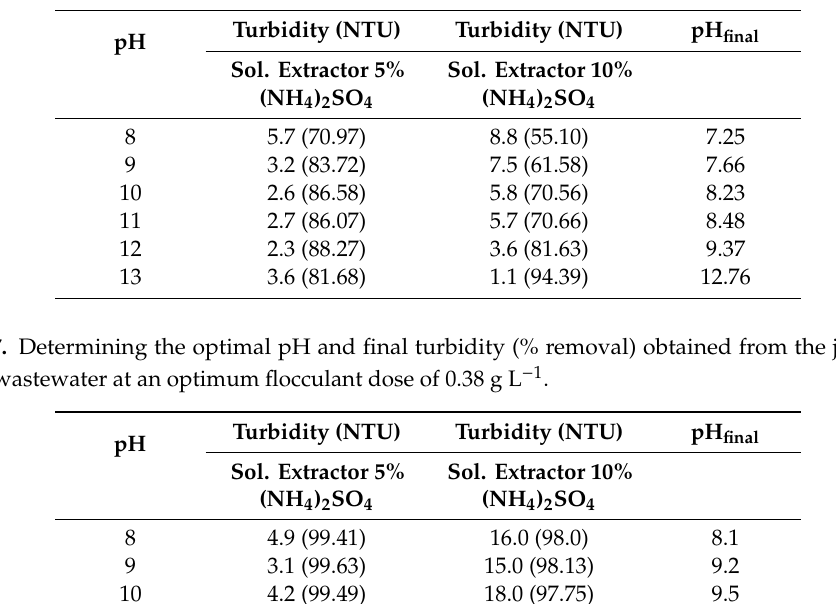
Table 6. Determining the optimal pH and final turbidity (% removal) obtained from the jar test in the